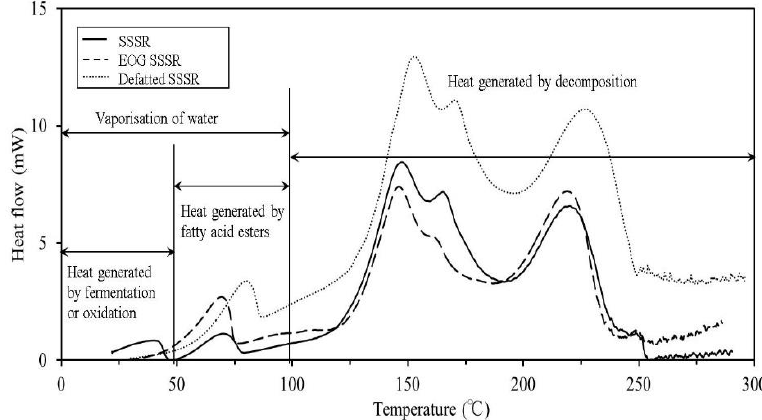
Figure 8. C80-calorimetry results for SSSR.